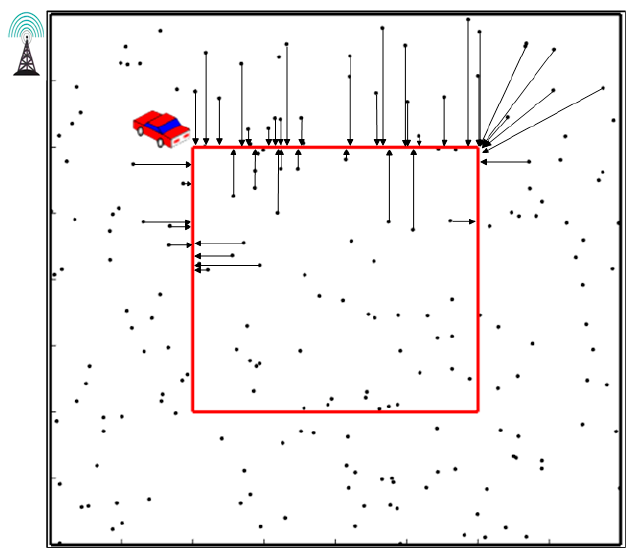
Figure 2. Data mule-based schema with a mobile collector.